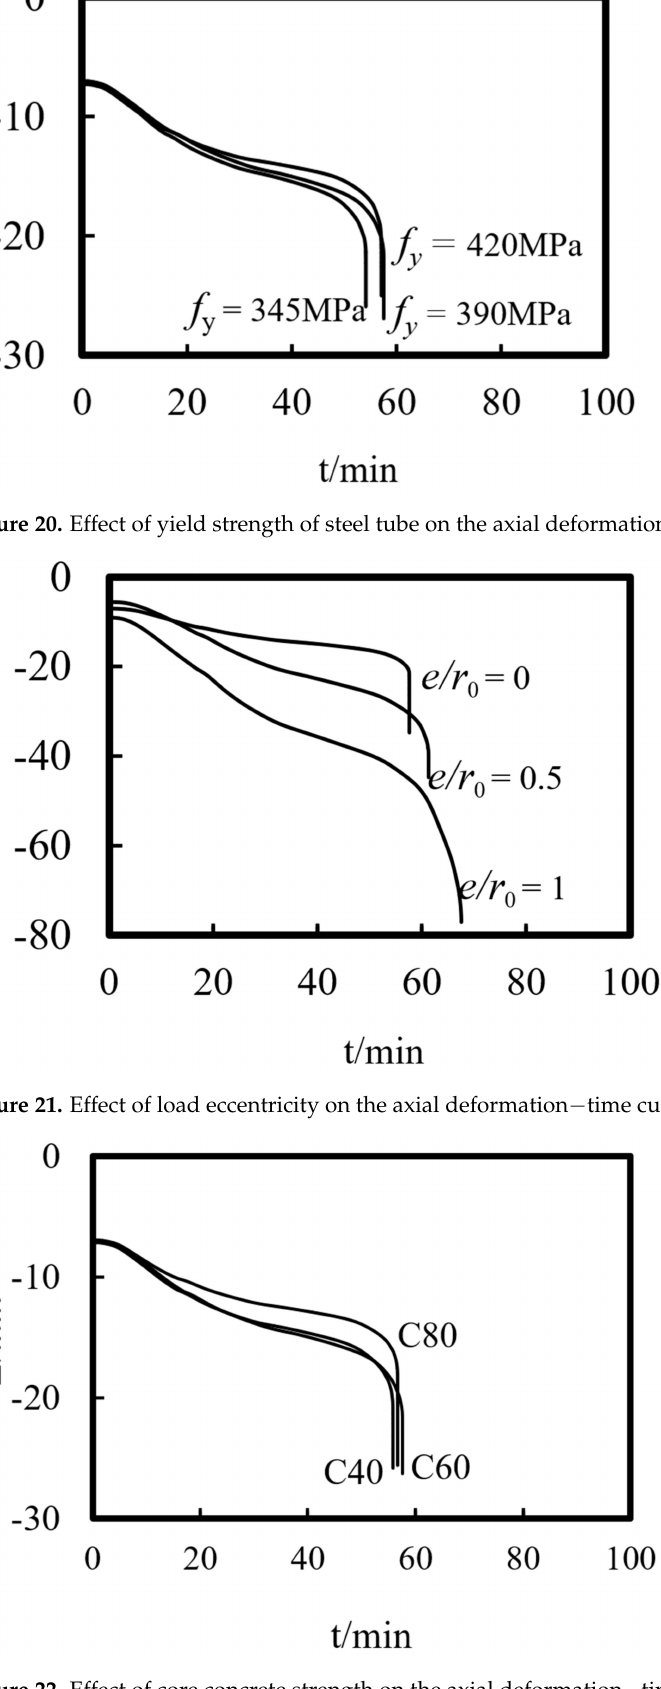
Figure 22. Effect of core concrete strength on the axial deformation − time